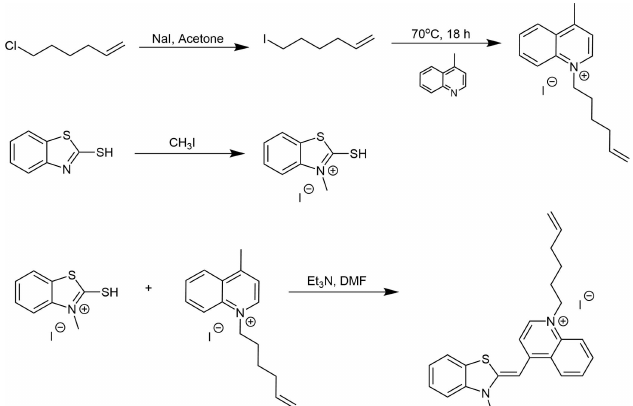
Figure 2 Crystal packing diagram of the title compound viewed down the b -axis direction with H atoms omitted for clarity.